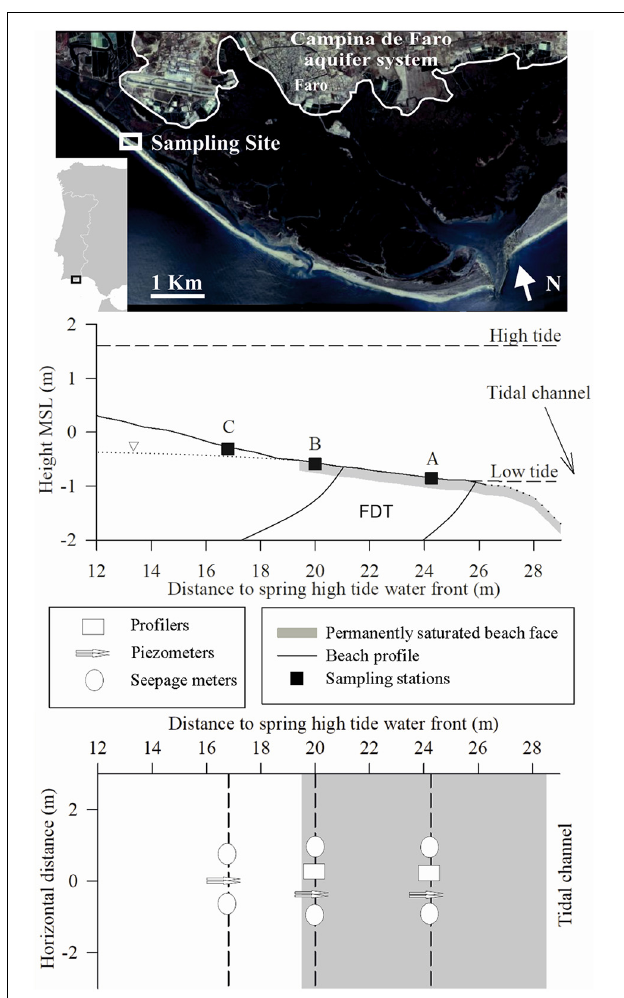
FIGURE 1 | Sampling site location at Ria Formosa coastal lagoon (SW Iberian Peninsula). The location of the three sampling stations (stations A and B within the permanently saturated beach face and station C upward) within the intertidal area of the inner part of Ancão peninsula and the distribution of samplers per station (seepage meters, piezometers, and profilers) are shown. A schematic view of beach water table during low tide, low and high tide marks, and the location of the NO 3 − -rich freshwater discharge tube (FDT) observed during the period 2005–2007 (Rocha et al., 2009) at our site are also